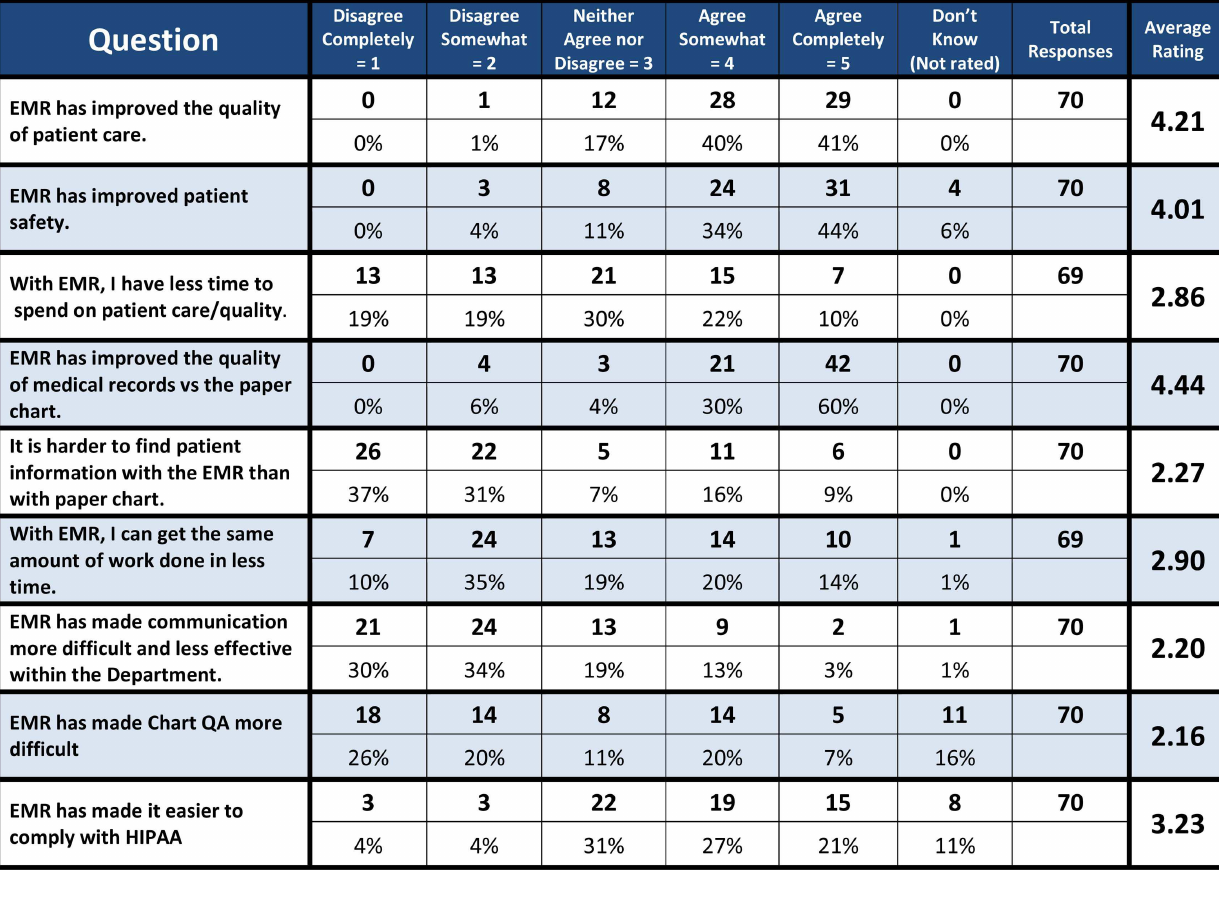
Table 7 | Results of a web-based survey of the Duke radiation oncology department on the EMR, conducted 1year after conversion from paper charts to the